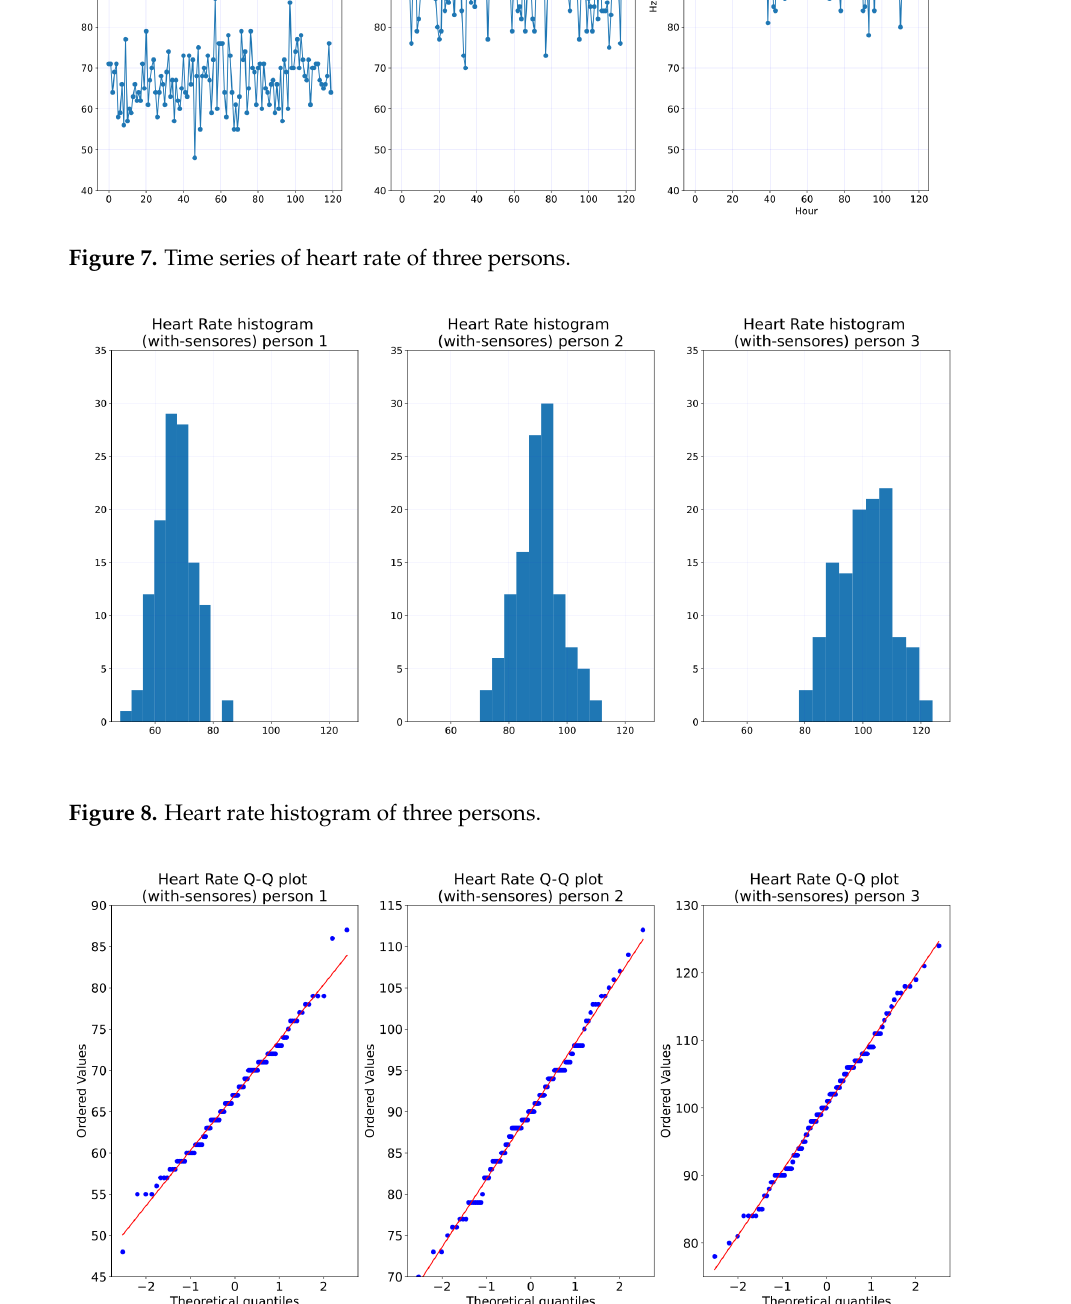
Figure 9. Heart Rate Q–Q plot of three